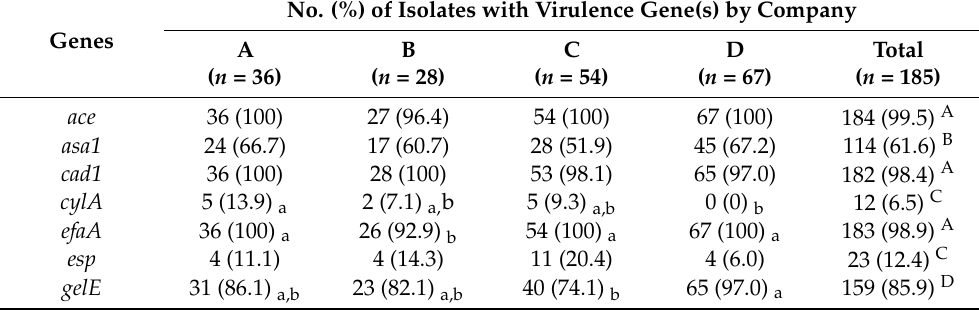
Table 5. Distribution of virulence genes of 185 high-level aminoglycoside-resistant Enterococcus faecalis isolated from the bulk tank milk of four dairy